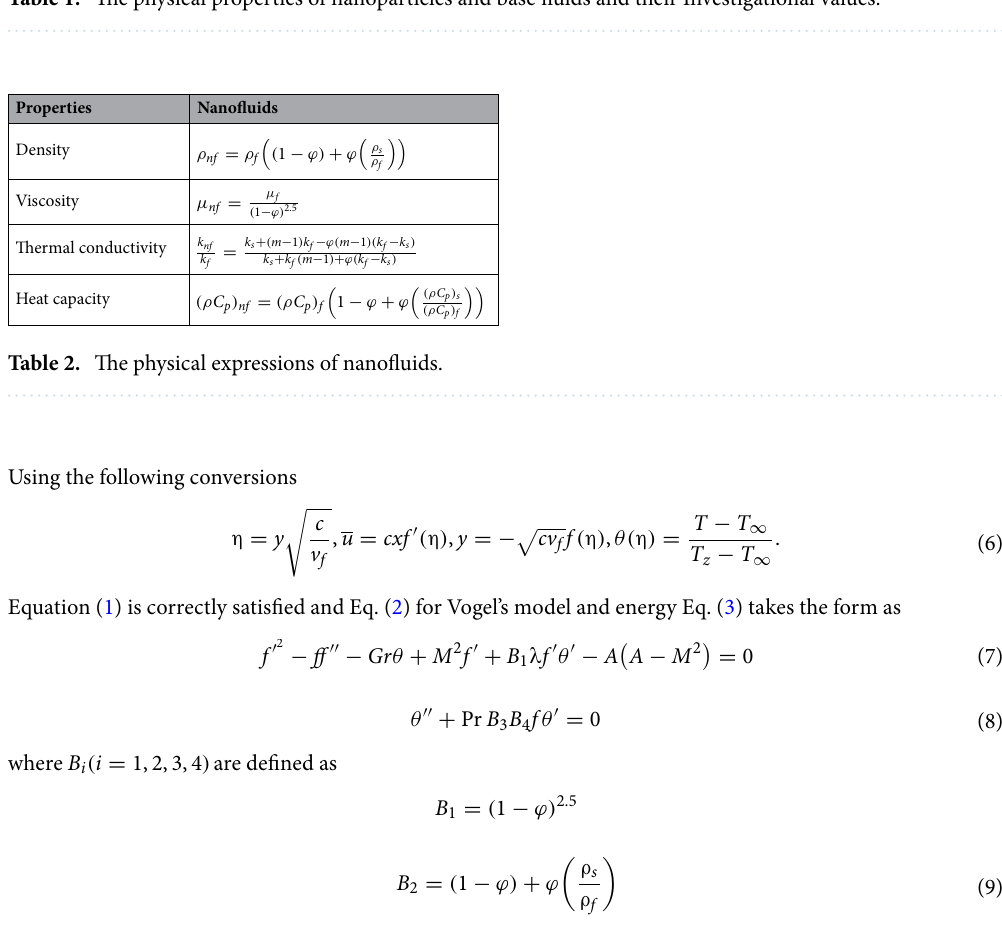
Table 1. The physical properties of nanoparticles and base fluids and their Investigational values.